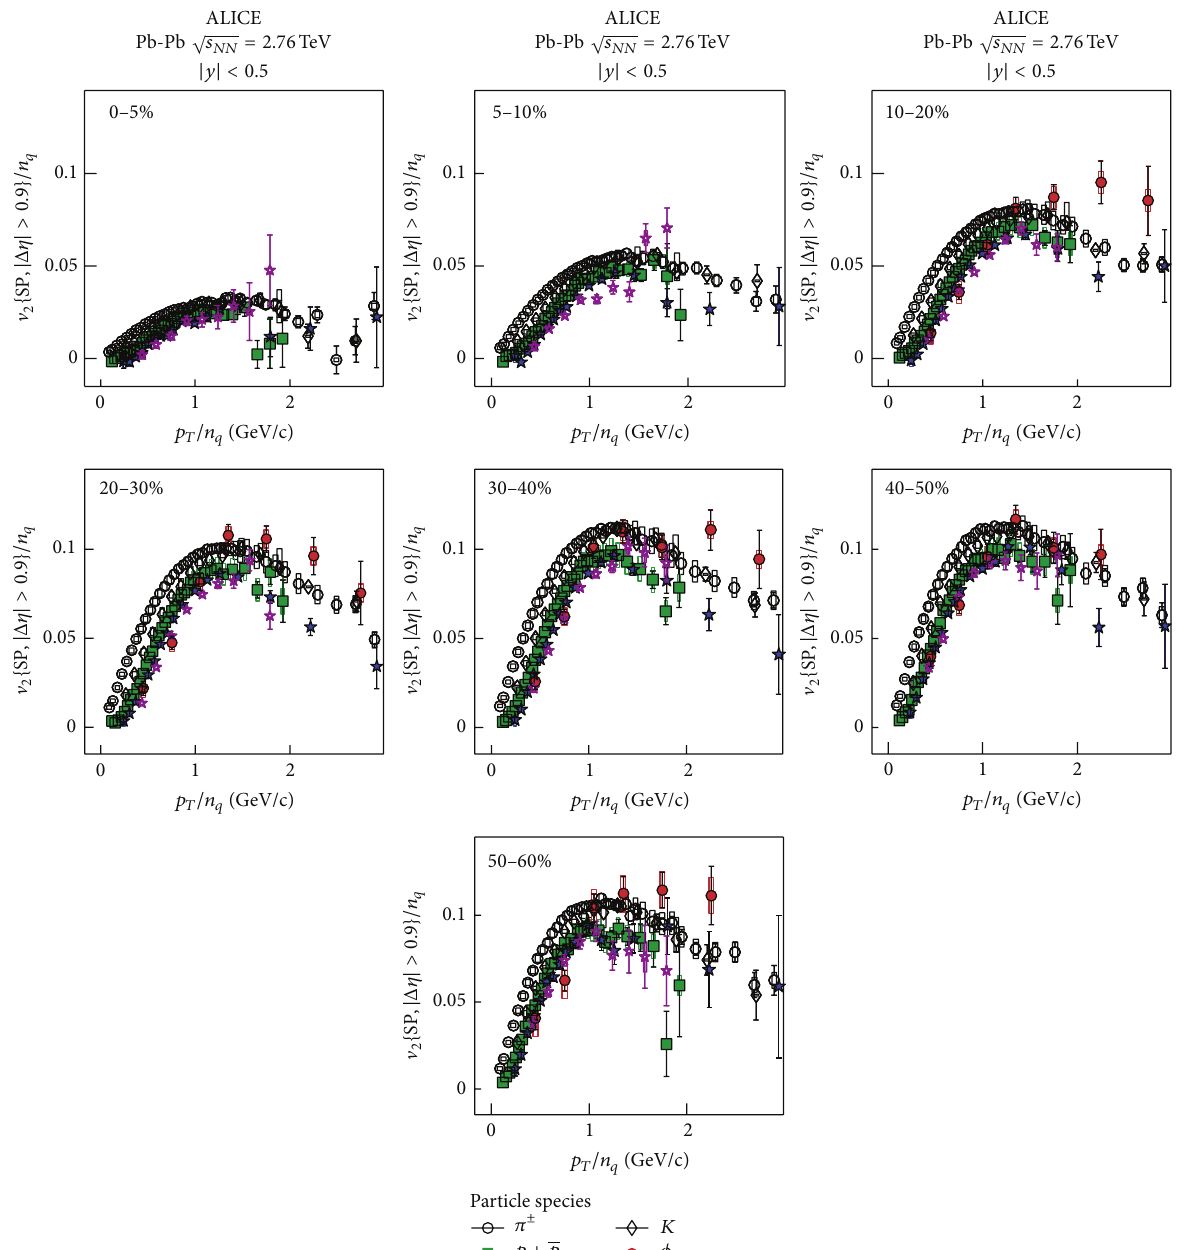
Figure 5: V 2 scaled by number of constituent quarks ( 𝑛 𝑞 ) as a function of 𝑝 𝑇 /𝑛 𝑞 for identified hadrons from Pb + Pb collisions at √𝑠 𝑁𝑁 = 2.76 TeV for various centrality intervals